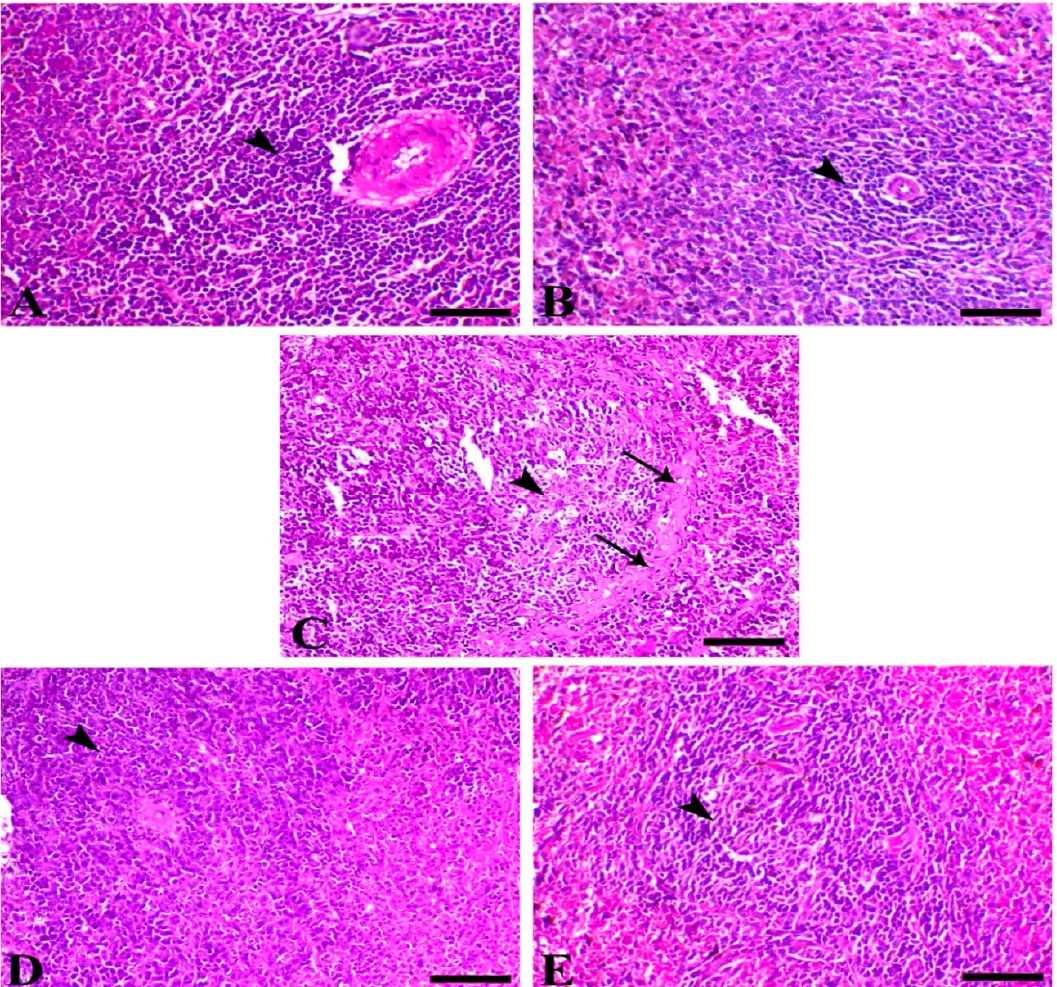
Figure 5. Spleen of different animal groups. ( A ) Control, ( B ) sham SMC50 (arrowheads indicate normal lymphoid follicle filled with numerous lymphocytes), ( C ) C + ve (arrowhead indicates marked lymphoid depletion and arrows indicate amyloid deposition), ( D ) C + SMC25, and ( E ) C + SMC50 both splenic sections showing marked improvement of lymphoid content (arrowheads). H&E stain, bar = 50 μ m.